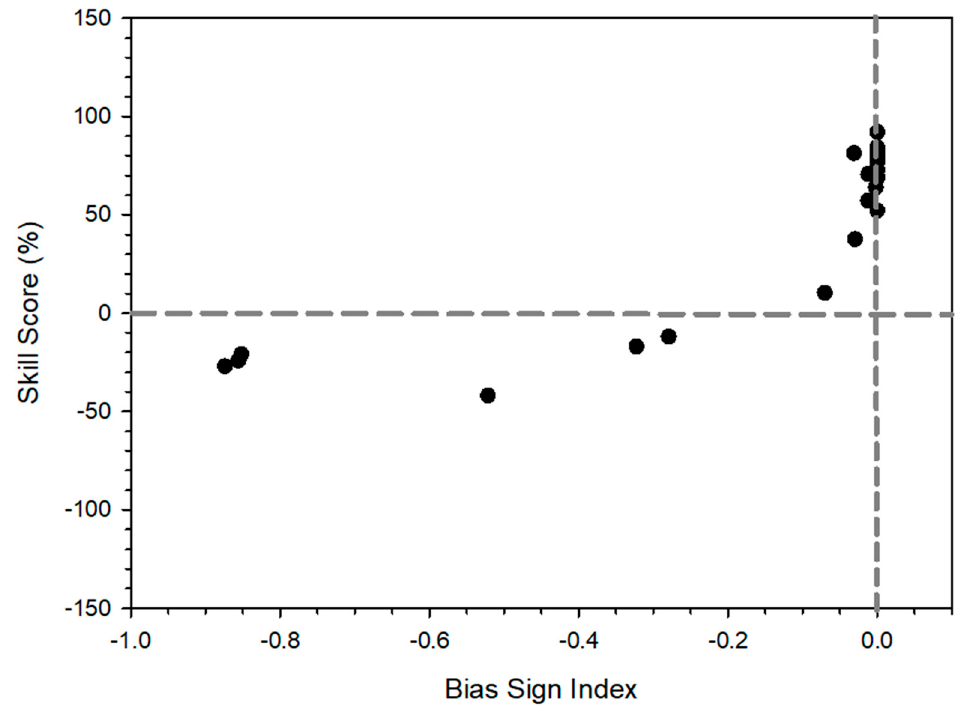
Figure 11. Scatter plot of Bias Sign Index and Skill Score for the clear sky global horizontal irradiance (GHI) at the Korea Institute of Energy Research (KIER) station. The definition of Bias Sign Index and Skill Score are explained in the main text.